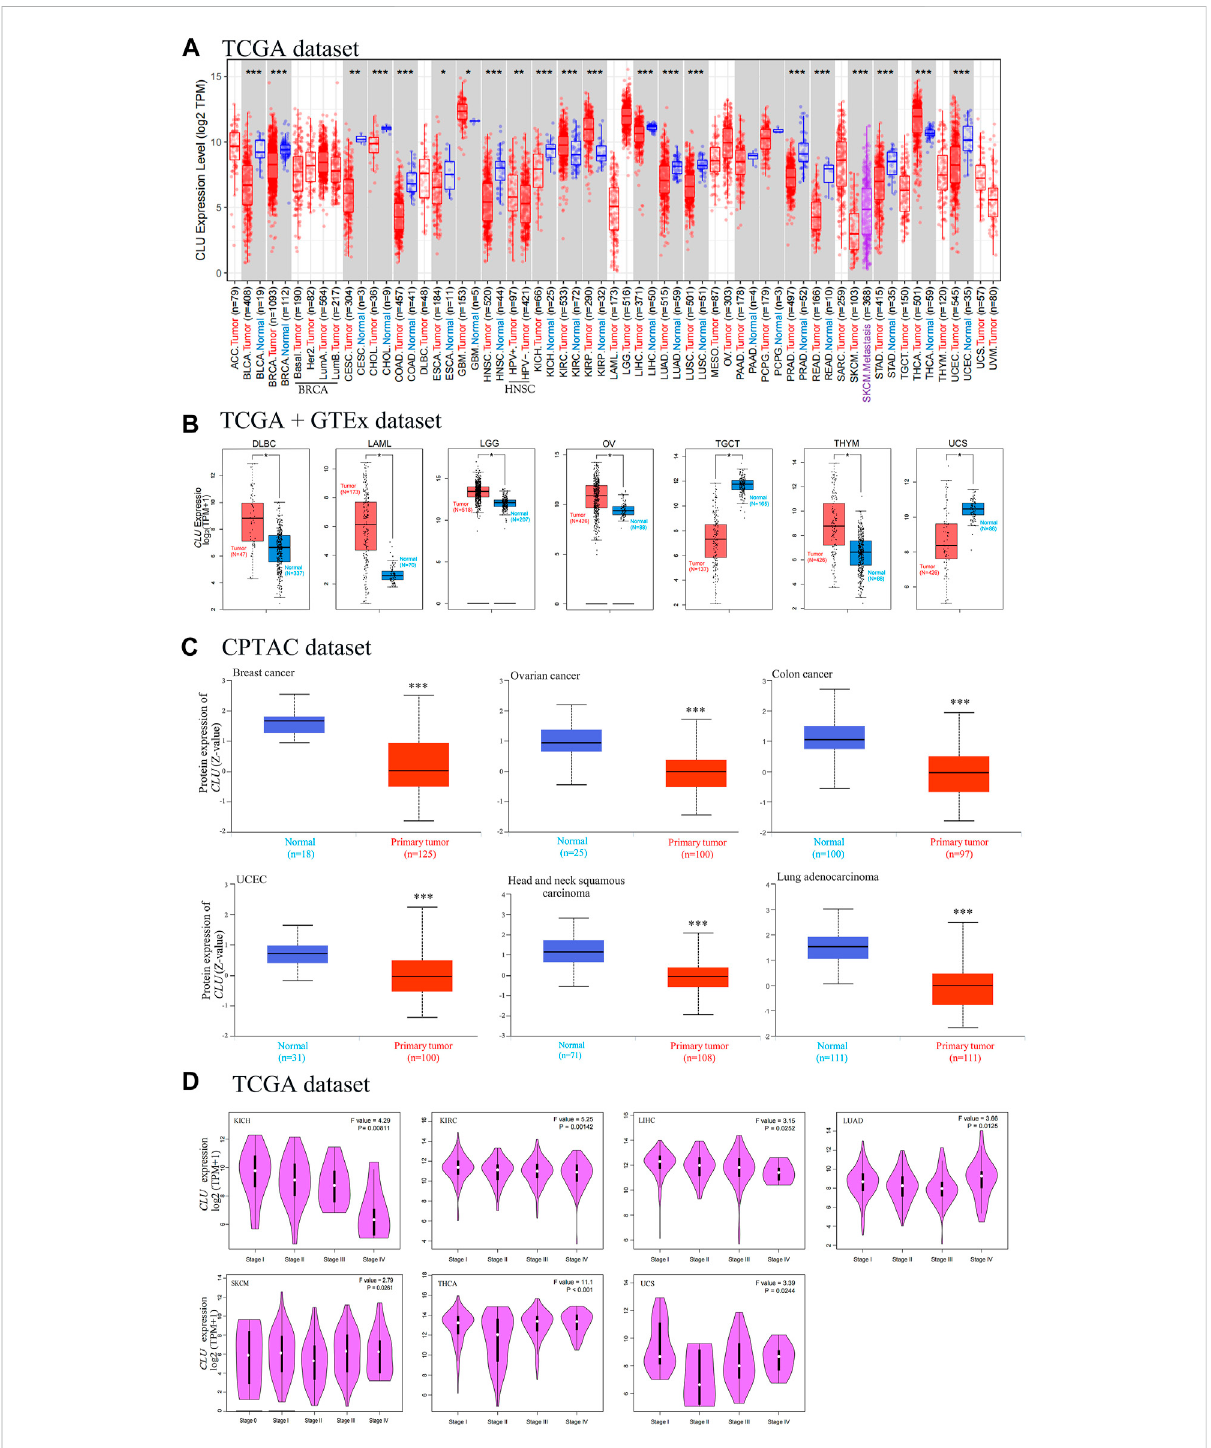
FIGURE 2 Degree of CLU expression in various tumor tissues and stages. (A) TIMER2 was used to assess the TCGA project ’ s CLU gene expression differences in distinct cancers or particular tumor subtype tissues and neighboring non-tumor tissues (* p < 0.05; ** p < 0.01; *** p < 0.001); (B) the matching non-tumor tissues were used as controls in the GTEx database, and GEPIA2 was utilized to examine CLU expression status among DLBC, LAML, LGG, OV, TGCT, THYM, and UCS cancers (* p < 0.05); (C) the CPTAC was utilized to compare CLU total protein expression in non-tumor andtumortissuesfromBC,CC,ovariancancer,UCEC,HNSC,andLUAD(*** p < 0.001); (D) throughutilizingTCGAdataset,GEPIA2wasusedfor CLU expression gene analysis at various pathological staging (stage I to V) in KICH, KIRC, LIHC, LUAD, SKCM, THCA, and UCS